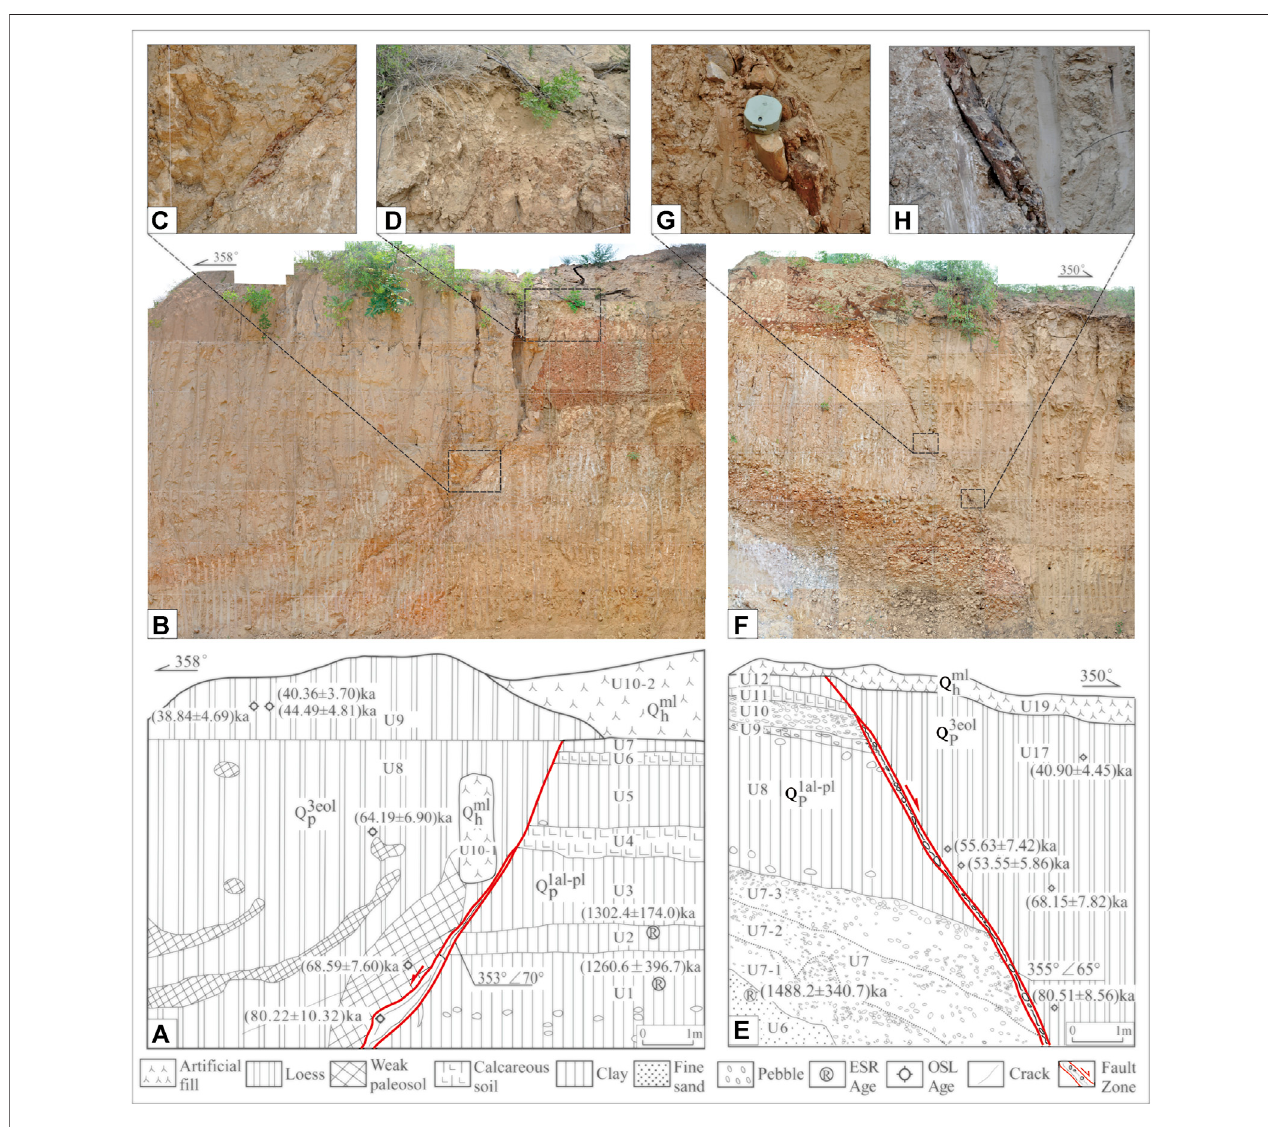
FIGURE3| ThephotographsandexplanationofTC1Trench(Left)andTC2Trench(Right)ofKoumaFault. (A) Thegeologicalpro fi leofTC1trench. (B) Thesplicing photographofTC1trench. (C) ThephotographoffaultzoneofTC1trench. (D) Thephotographofup-breakpointofTC1trench. (E) Thegeologicalpro fi leofTC2trench. (F) The splicing photograph of TC2 trench. (G) The photograph of fault zone of TC2 trench. (H) The photograph of fault zone of TC2 trench.